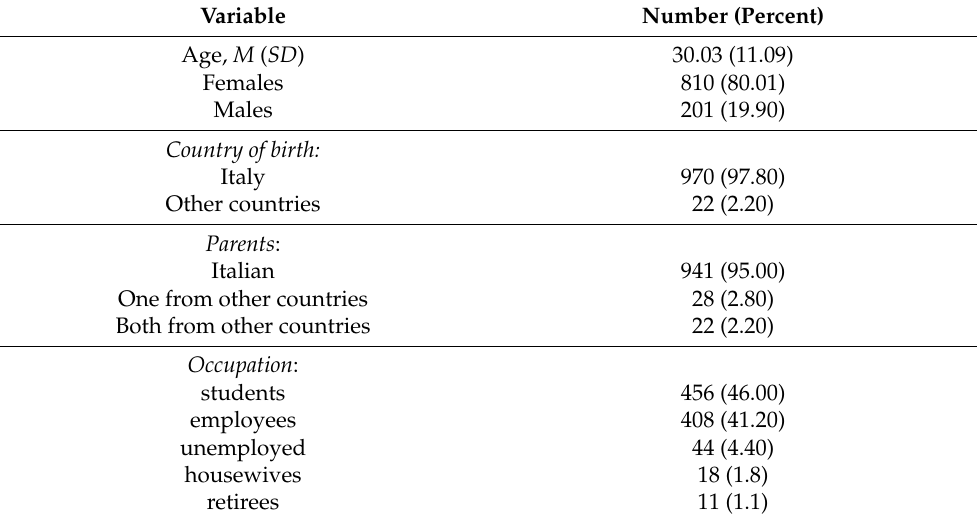
Table 1. Sample characteristics ( n =